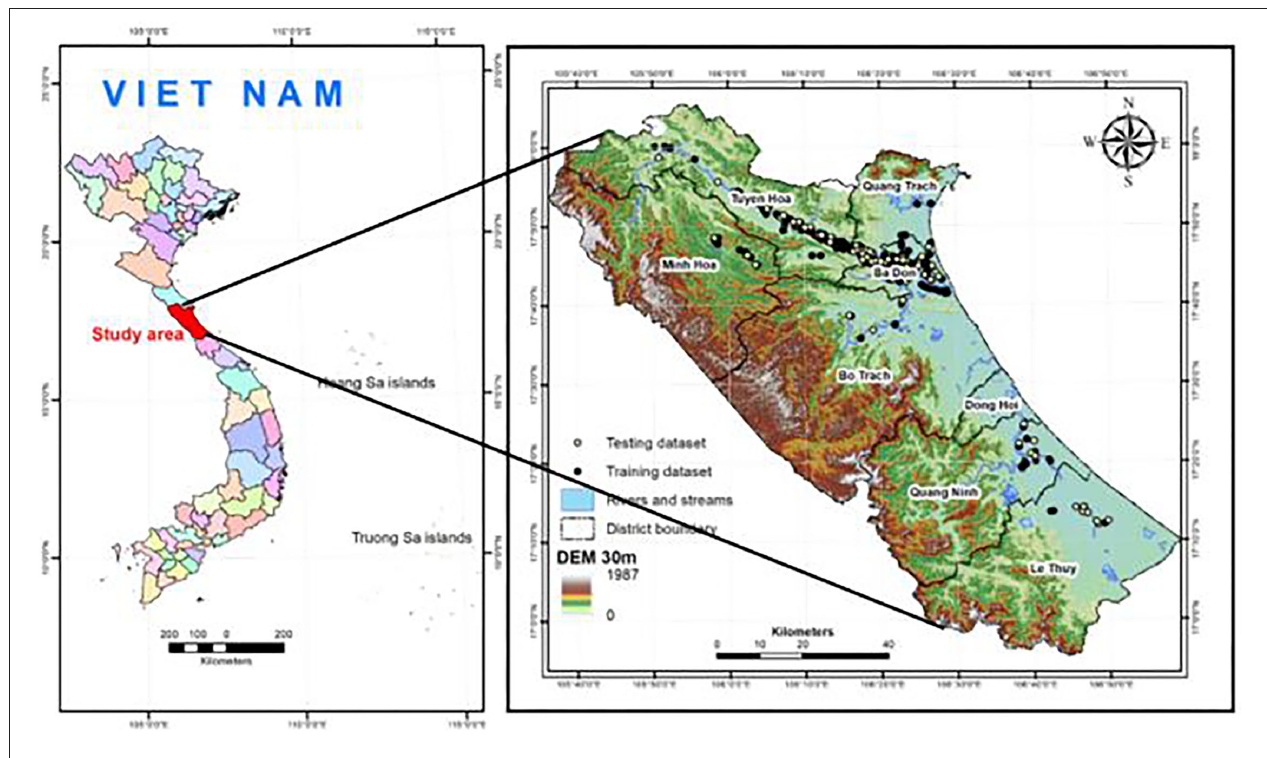
FIGURE 1 | Quang Binh province in Vietnam’s map.